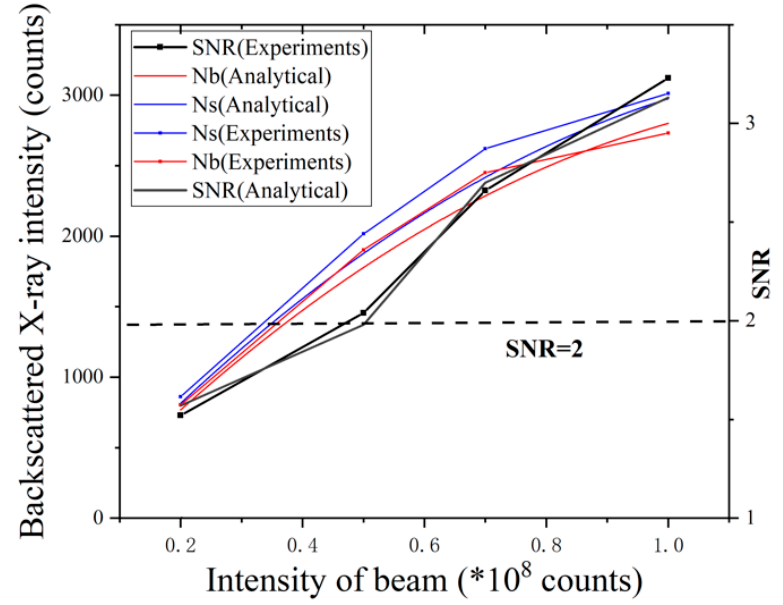
Figure 13. The e ff ect of X-ray beam intensity on backscattered X-ray intensity signals. Figure 13. The effect of X-ray beam intensity on backscattered X-ray intensity signals.